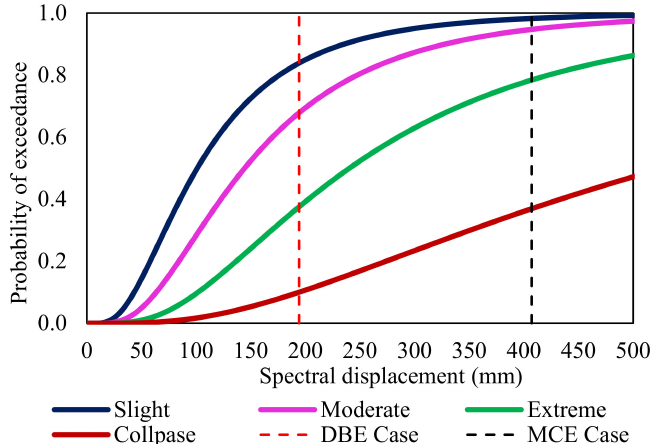
Figure 13. Fragility curve for unsymmetrical building Case II (R = 4).